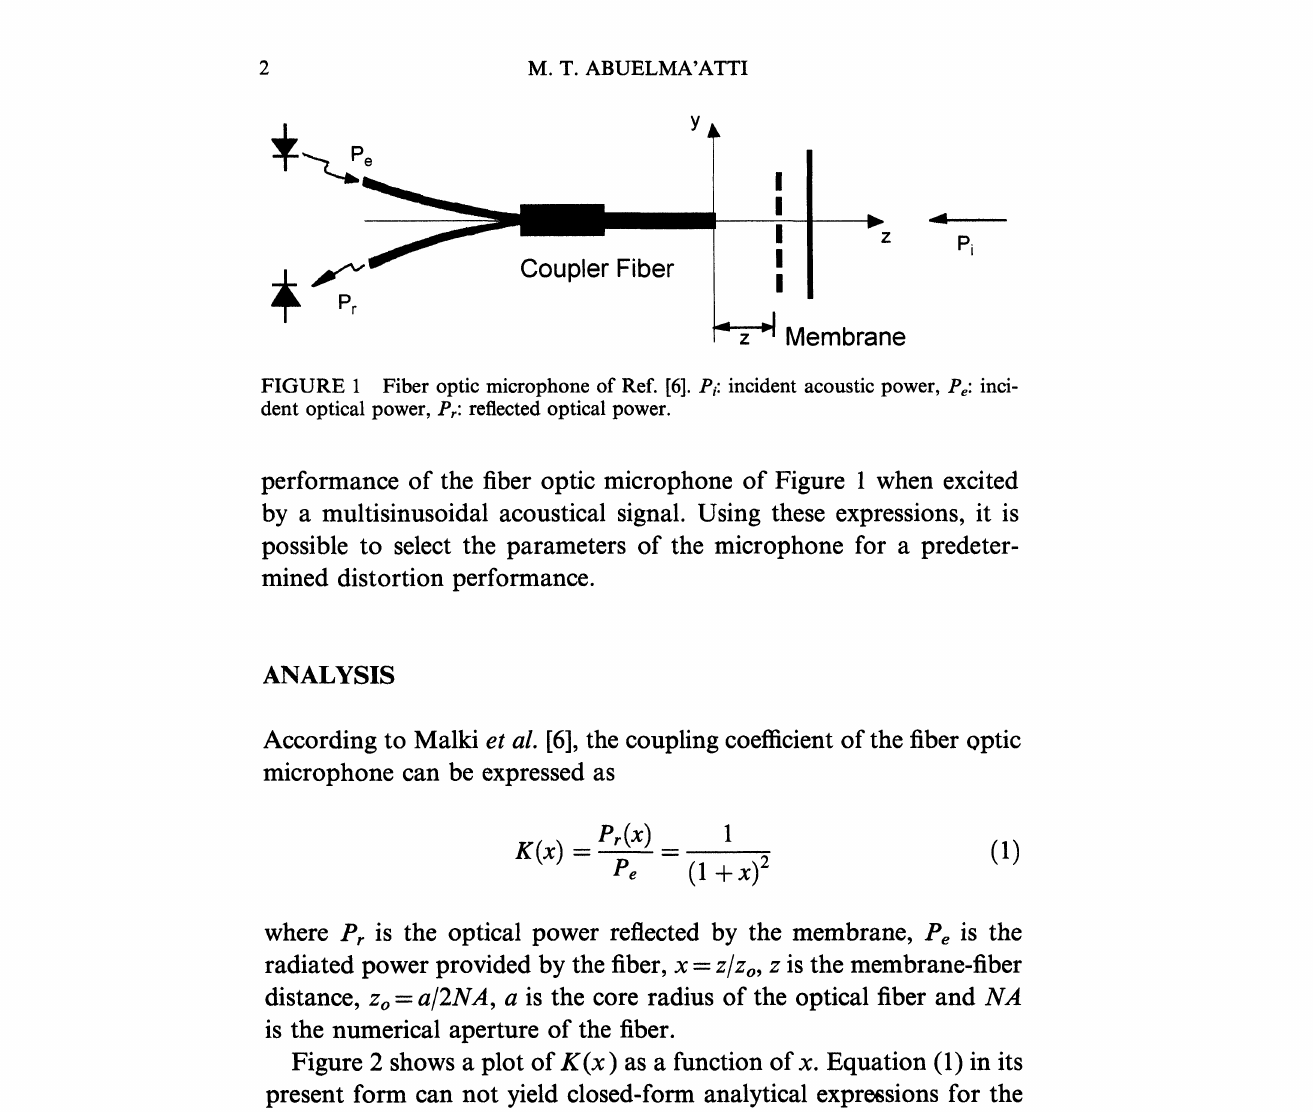
FIGURE Fiber optic microphone of Ref. [6]. Pi: incident acoustic power, Pe: inci- dent optical power, Pr: reflected optical power.